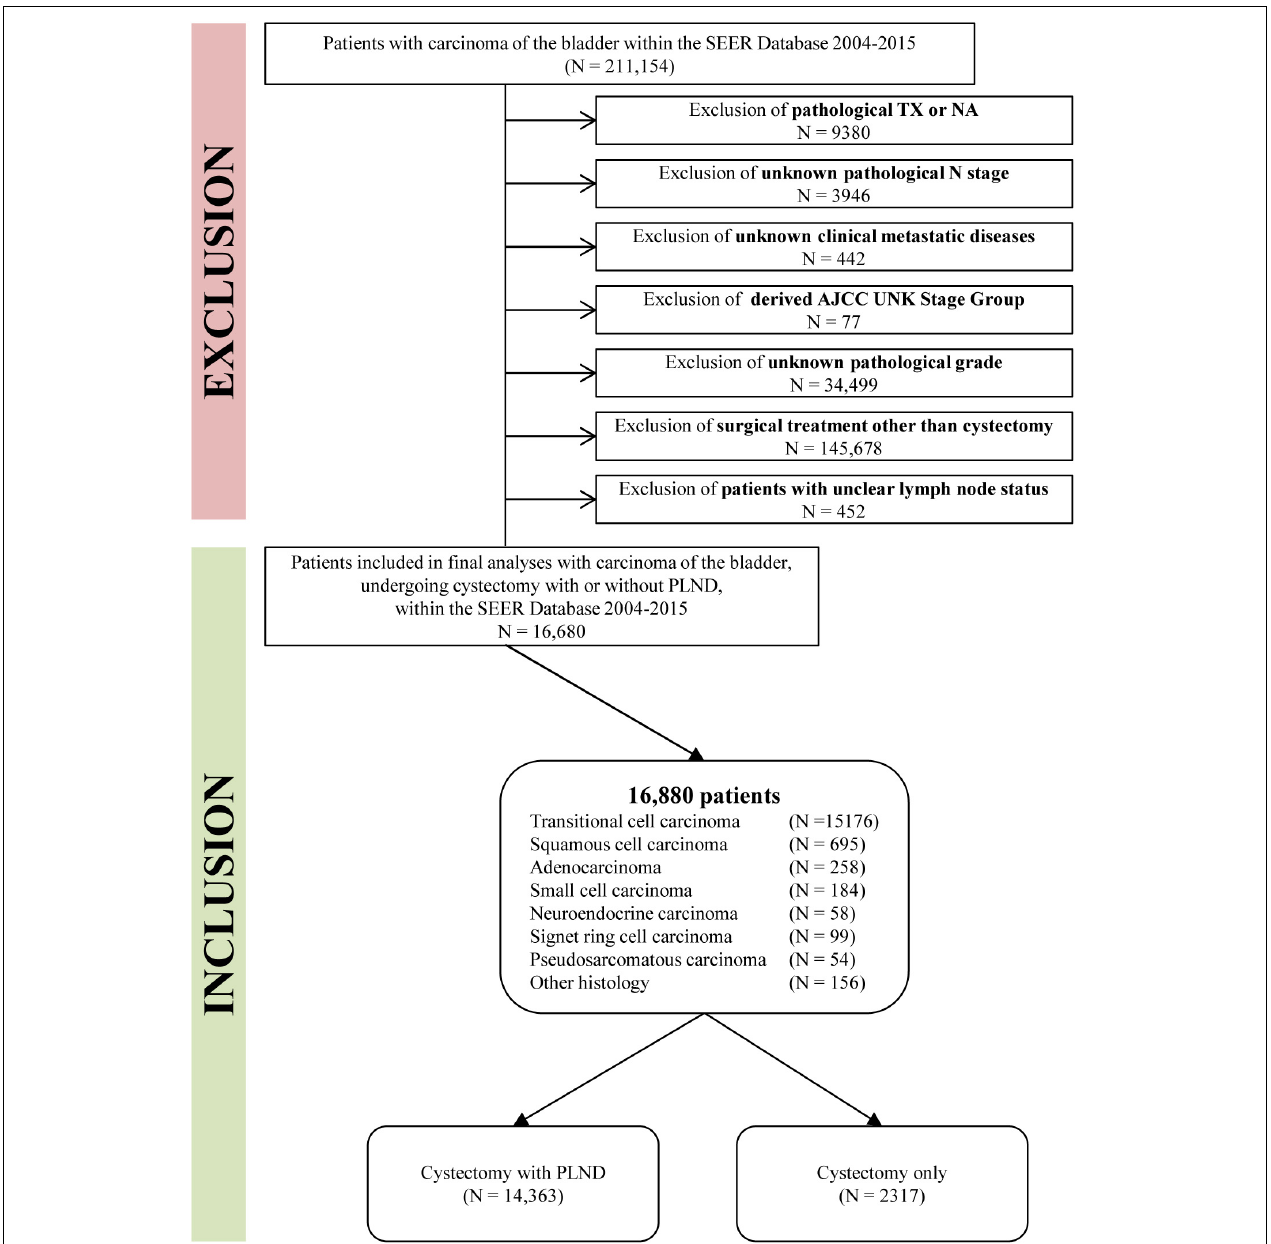
FIGURE 1 | Flowchart describing the selection of bladder cancer patients who underwent cystectomy with or without pelvic lymph node dissection (PLND) within the SEER from 2004 to 2015.